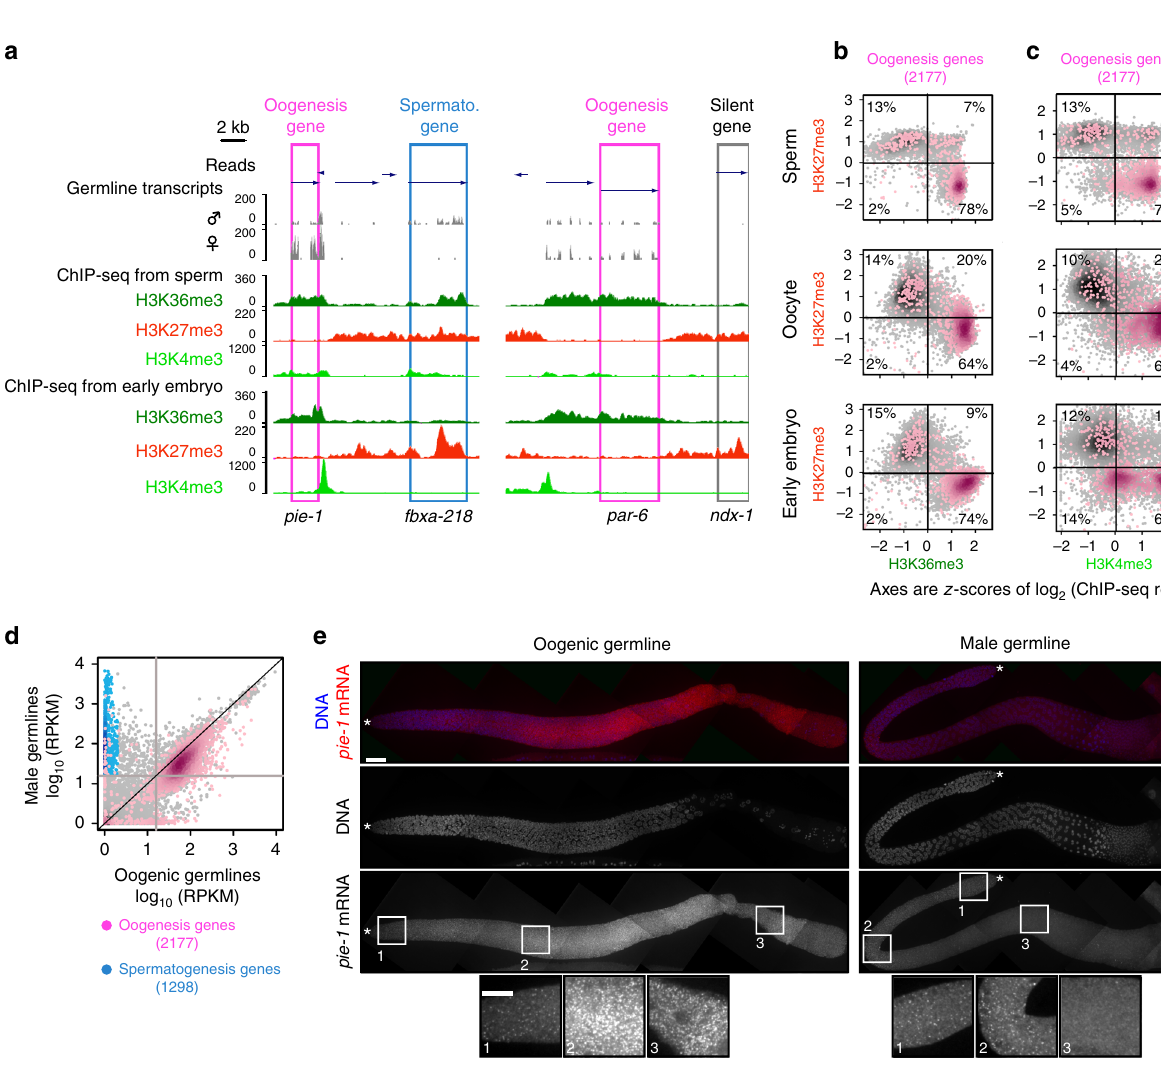
Fig. 3 “ Oogenesis genes ” are marked with active modi fi cations in sperm and are transcribed in male germlines. a – c Genome-browser views and scatter plots as described for Fig. 2, highlighting genes de fi ned as “ oogenesis genes ” (Methods) in pink. Classes of genes are shown in separate panels in Supplementary Fig. 5. d Comparison of spermatogenic vs. oogenic germline transcriptomes, highlighting spermatogenesis genes (blue) and oogenesis genes (pink). Axes show log-transformed RPKMs after adding a pseudo-count of 1. The gray lines show the cutoff for expressed genes (RPKM of 15, Methods). The number of biological replicates for spermatogenesis germlines was 6 and for oogenesis germlines was 3. e smFISH images of RNA from a well-known oogenesis gene pie-1 in oogenic and male germlines. Top panels are z-stack projections with the distal tip marked with *. Bottom panels are high-magni fi cation views of the boxed regions (projection of 3 slices). For both oogenic and male germlines, 10 – 20 gonads were visually examined under the microscope and at least 3 germlines were imaged. Scale bars represent 20 μ m for the top panels and 10 μ m for the bottom